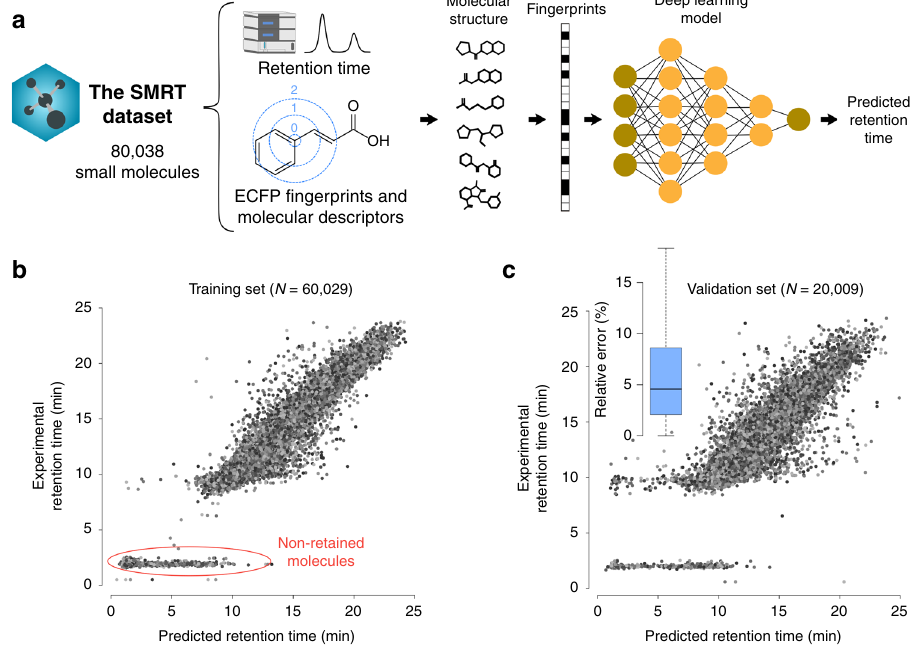
Fig. 1 RT prediction results. a Composition of the SMRT dataset and structure of the deep-learning model. b Predicted vs experimental RT for the training set and c validation set. Non-retained molecules are indicated (tentatively) in the training set plot. The relative prediction error box plot for the validation set is also shown. The box plot represents median value and interquartile range (25 – 75 % percentiles) excluding